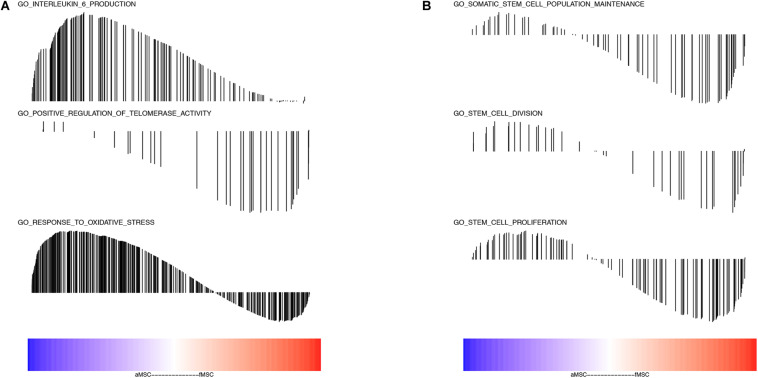
Analyses of gene sets related to aging and stem cell self-renewal. (A) Interleukin 6 production (NES = 1.939, FDR q-value = 0.019); positive regulation of telomerase activity (NES = –1.616, FDR q-value = 0.021); response to oxidative stress (NES = 1.4371426, FDR q-value = 0.076). (B) Somatic stem cell population maintenance (NES = –1.378, FDR q-value = 0.069); stem cell division (NES = –1.207, FDR q-value = 0.158); stem cell proliferation (NES = –1.266, FDR q-value = 0.046). The color bar indicates the sort order of genes (blue represents up-regulated in aMSC group and red represents up-regulated in fMSC group). The location of vertical bar indicates the occurrence of that gene within the ranked list and the height of the bar indicated the enrichment score.